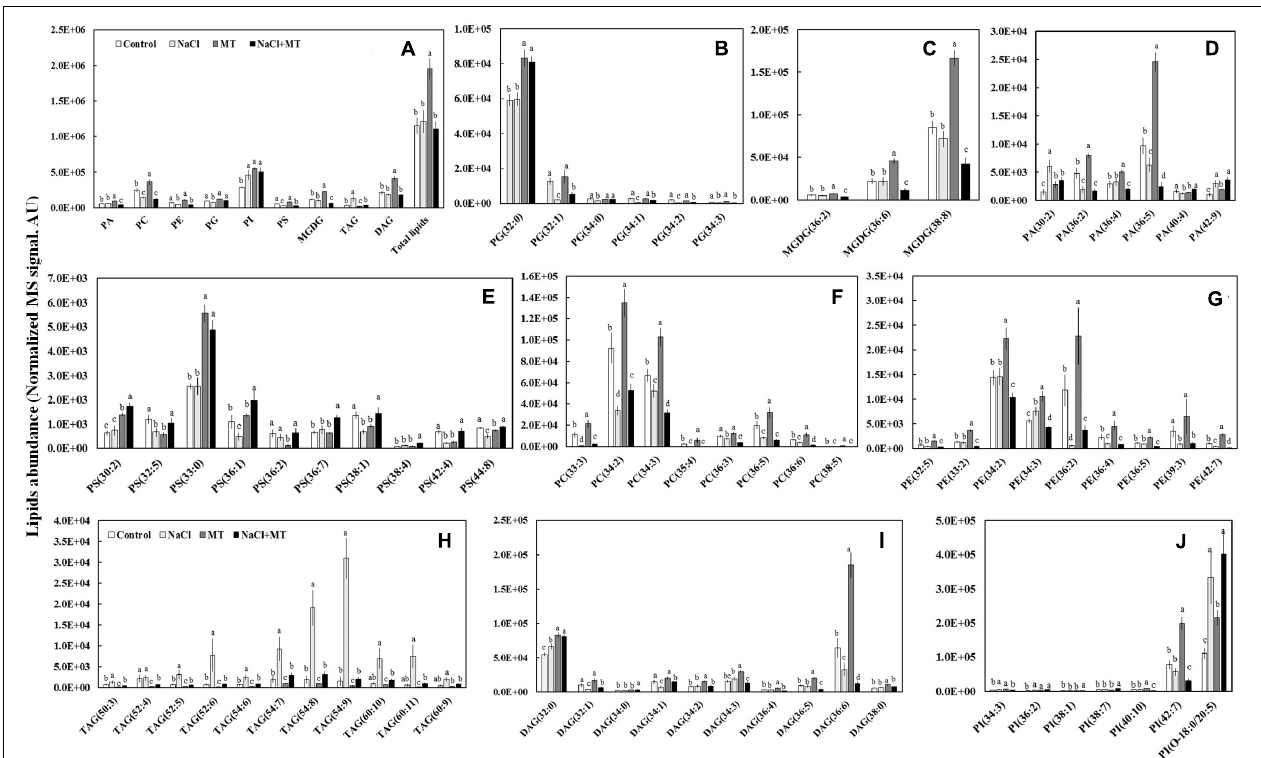
FIGURE 5 | Effects of MT on the leaf lipidome in NaCl-stressed or non-stressed Xu 32. Xu 32 seedlings were pretreated with 0.5 µ M (root) + 100 µ M (leaf) MT for 3 days and then subjected to 150 mM NaCl stress. The mature leaves were collected at the same position after 7 days of NaCl treatment for lipidomic profiling. (A) Total amount of lipids in various head group classes. (B–J) Abundance of lipid molecular species of nine main lipid classes. Each column is the mean of five repetitions, and columns labeled with different letters indicate significant difference at P <